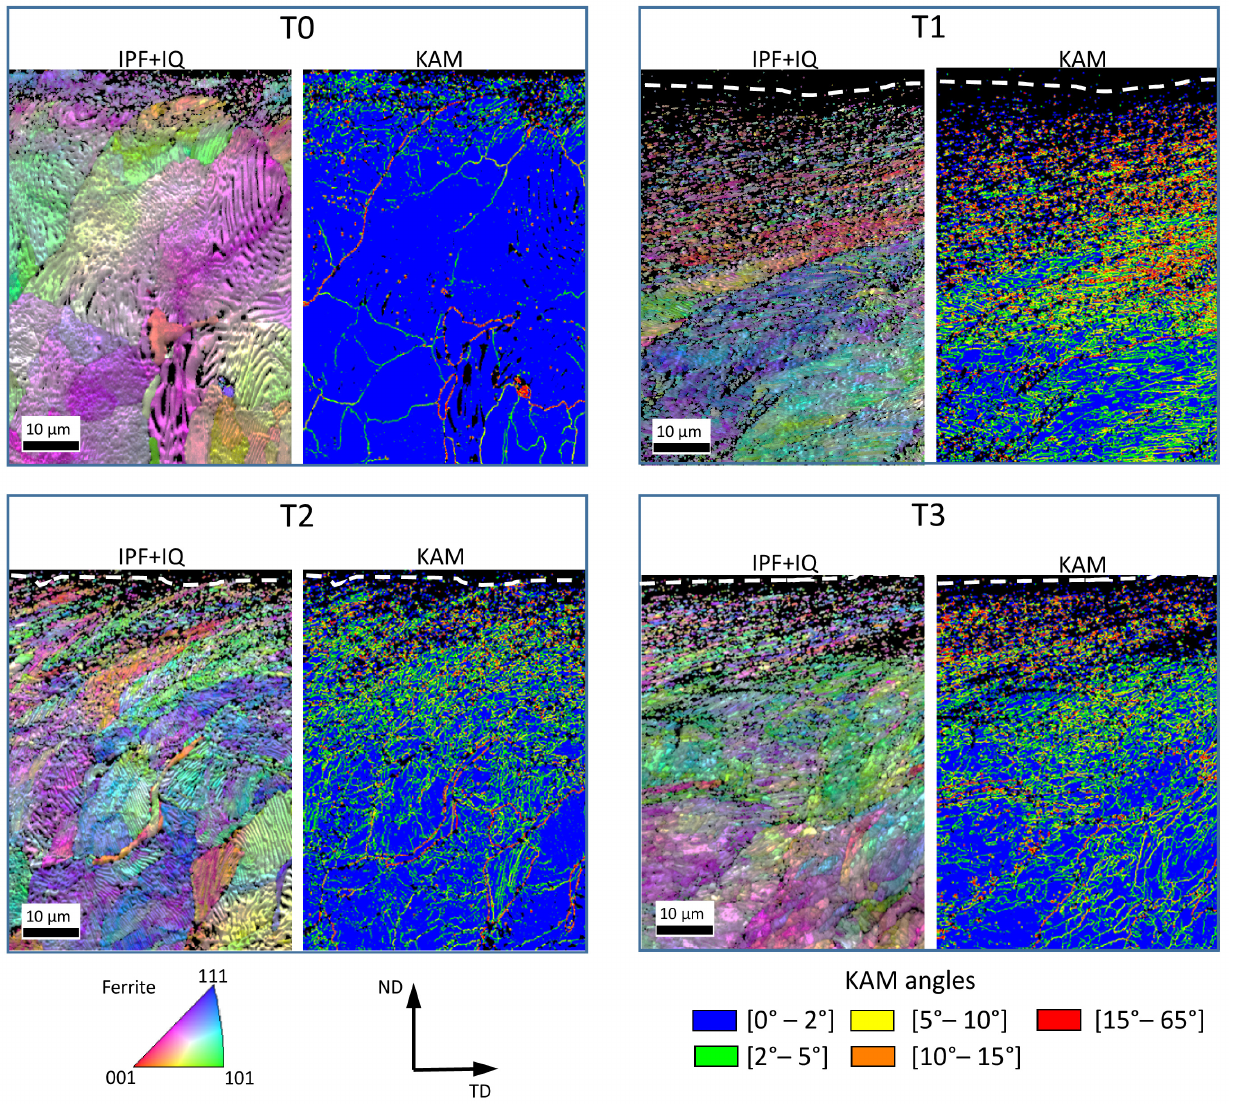
Figure 5. IPF map with IQ and KAM maps for the non-deformed state (T0) and the different testing conditions (T1, T2, T3), for Ring AT. The measurements were performed along the transverse direction.